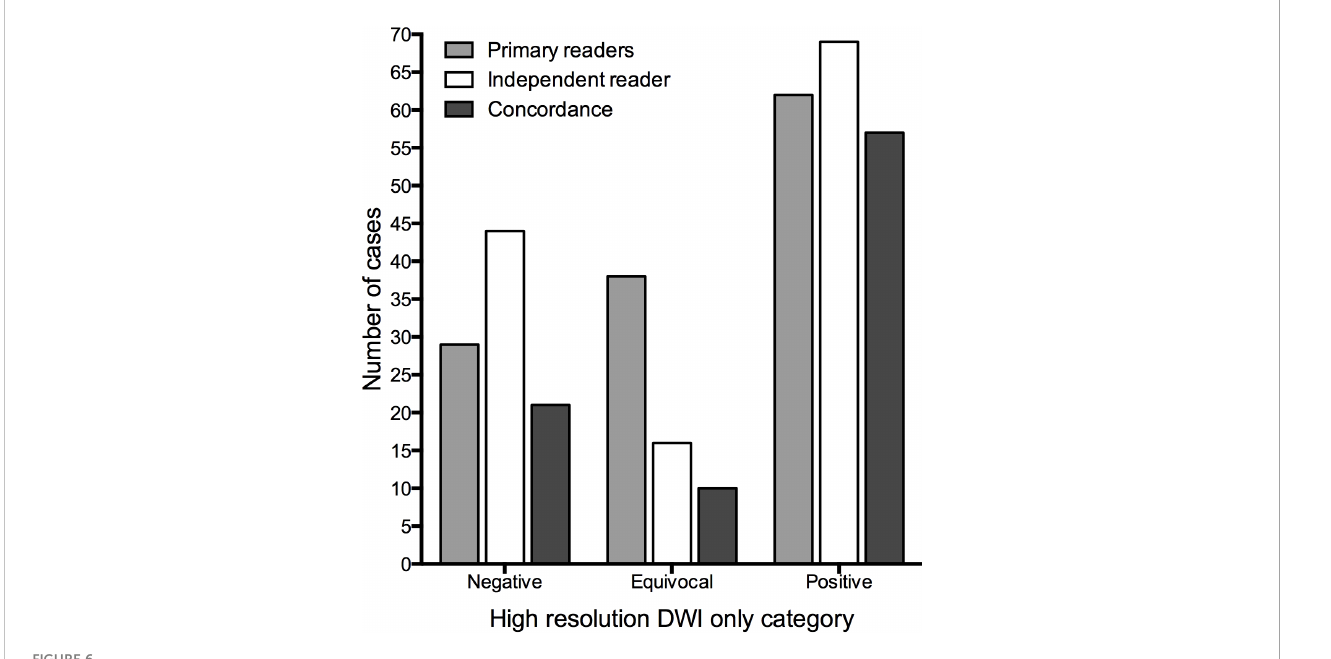
FIGURE 6 Comparison of the primary and the independent readings of high-resolution DWI-only.